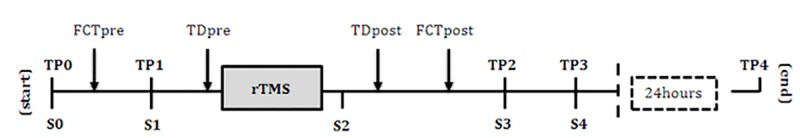
Testing protocol timeline.FCTpre & FCTpost: food challenge task before and after rTMS. TDpre & TDpost: temporal discounting task before and after rTMS. Collection of main visual analogue scales (VAS) at TP0 (pre-FCT); main VAS & additional VAS at TP1 (post-FCT/pre-rTMS) & TP2 (post-rTMS & FCT); main VAS only at TP3 (end of session) & TP4 (24 hours following). Saliva samples collected at S0 (pre-FCT), S1 (post-FCT/pre-rTMS), S2 (immediately after rTMS), S3 (post-rTMS/post-FCT) and S4 (end of session).